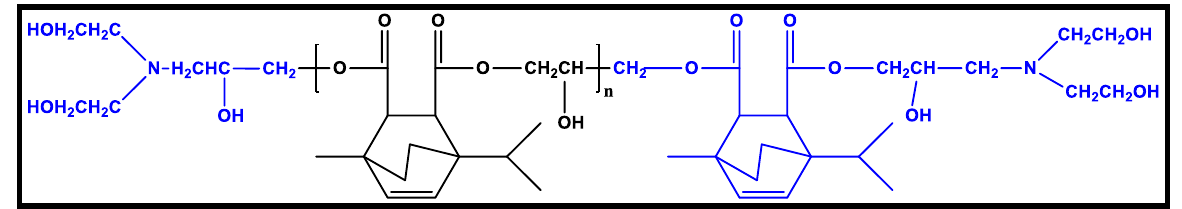
Figure 7. Chemical structure of polyols based on terpene [65].